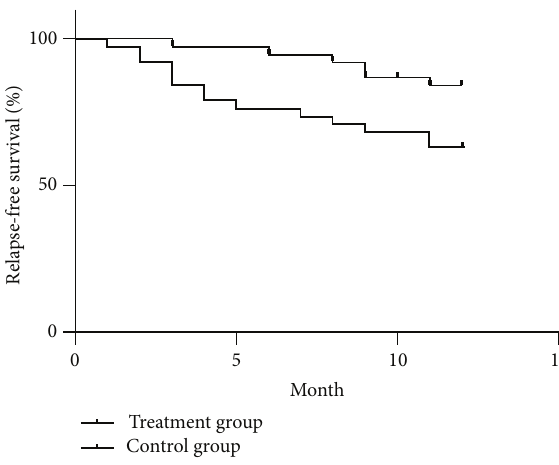
Figure 2: Kaplan-Meier survival curves for relapse-free Survival between the treatment group and the control group. Table 2: Comparison of the serum prolactin/estradiol levels between two groups at the second week and the second month after